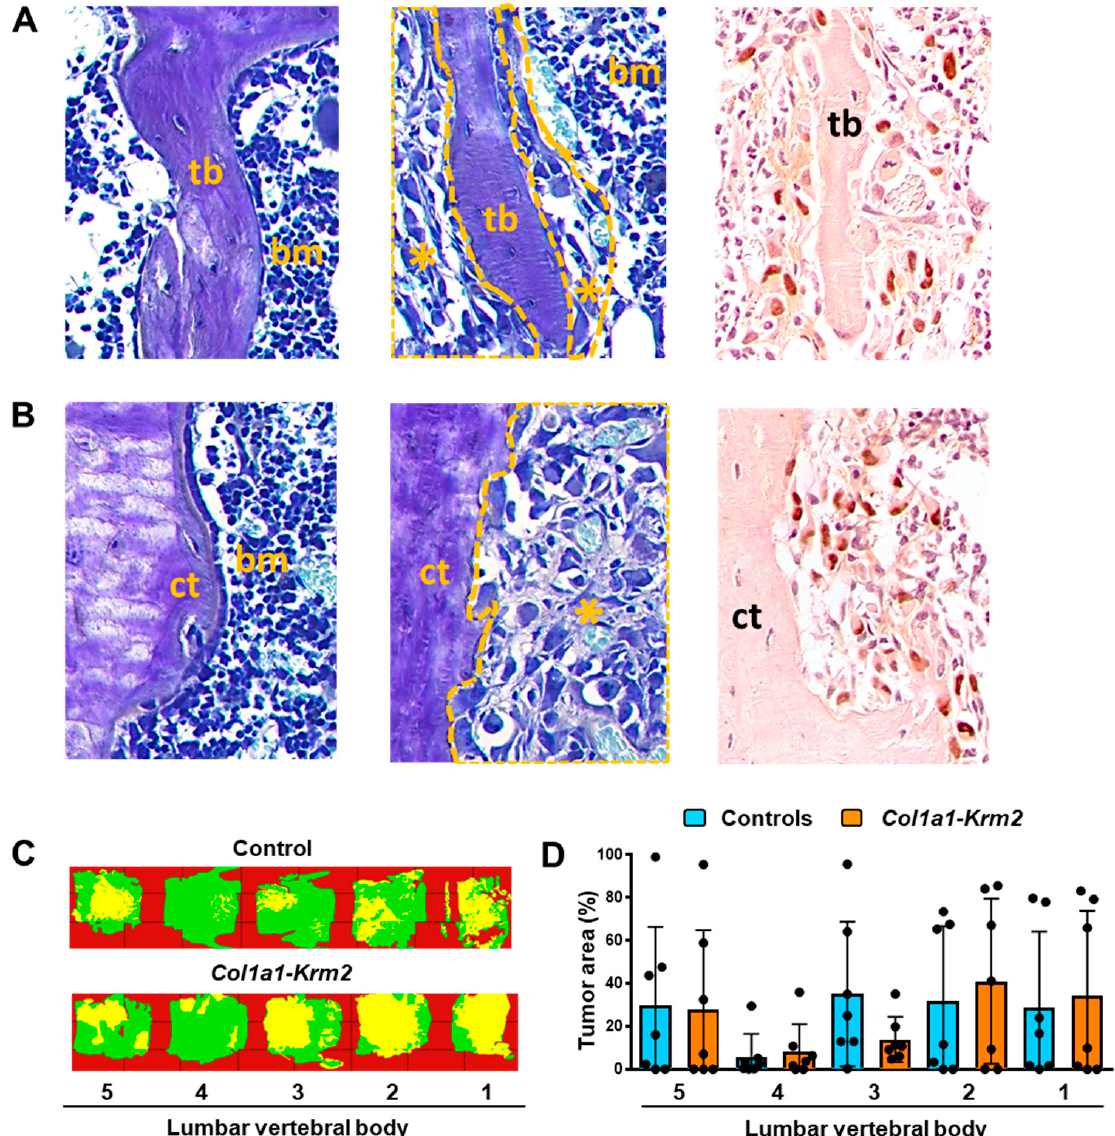
Figure 4. The Col1a1-Krm2 transgene does not affect metastatic outgrowth in the lumbar spine of NSG mice. ( A ) Representative toluidine blue staining of trabecular bone (tb) areas in undecalcified lumbar spine sections from an injected NSG mouse. The panels show tumor-free bone areas surrounded by bone marrow (bm) (left), tumor-burdened areas (*) (middle) and immunohistochemistry with a cytokeratin-specific antibody (right). ( B ) Representative toluidine blue staining of cortical bone (ct) areas in the same sections. The panels are organized as described in ( A ). ( C ) Tumor cell distribution in representative lumbar spines of an injected NSG and Col1a1-Krm2 -transgenic NSG mouse. Areas representing unaffected bone marrow (green) or infiltrated tumor cells (yellow) are indicated by pseudocolours. ( D ) Quantification of the tumor area in individual lumbar vertebral bodies (L1 to L5) of all experimental mice. Data represent mean ± standard deviation ( n = 7). Statistical significance was determined by Student’s t -test.